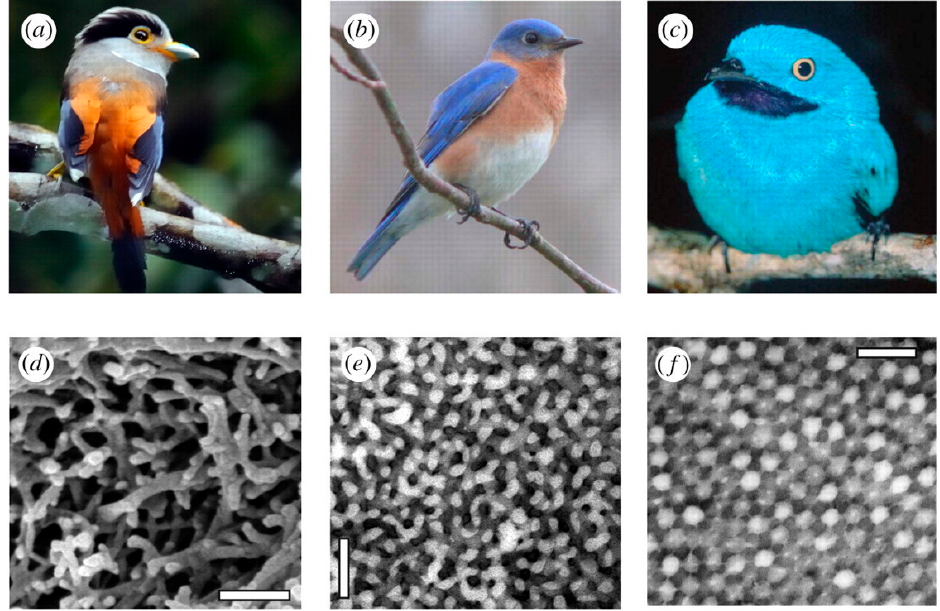
Figure 18. Examples of colorful feathers in birds. ( a ) Female silver-breasted broadbill ( Serilophus lunatus , Eurylaimidae). ( b ) Male eastern bluebird ( S. sialis , Turdidae). ( c ) Male plum-throated cotinga ( Cotinga maynana , Cotingidae). ( d ) Scanning electron microscopy photograph of the basic nanostructure with a thin ( ≤ 1 μ m) disordered layer of spongy β -keratin bars, at the periphery of medullary barb cells from the pale blue-grey primary covert feathers of S. lunatus , ( e ) Transmission electron microscopy photograph of the channel-type nanostructure made of β -keratin and air in the barb cells from the royal blue contour feathers of S. sialis . ( f ) Transmission electron microscopy photograph of the sphere-type nanostructure made of β -keratin and air in barb cells of the dark turquoise blue contour feathers of C. maynana . Scale bars: ( d ) 250 nm; ( e , f ) 500 nm. Photo credits: ( a ) Yiwen Yiwen; ( b ) Ken Thomas; and ( c ) Thomas Valqui [263]. © The Royal Society Publishing.